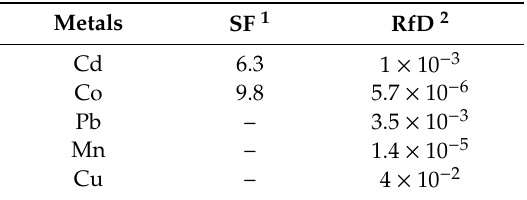
Table 1. Slope factor and the reference dose entering the human body through the respiratory route for human health risk assessments